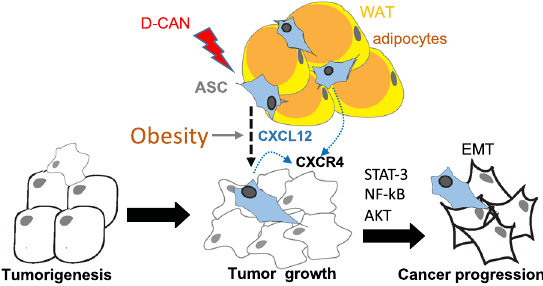
Fig. 6 The model of CXCL12 role in cancer progression. Adipose stromal cells (ASC) derived from WAT are the principal source of CXCL12 driving cancer by increasing the survival and proliferation of cancer cells and subsequently their EMT and aggressiveness via CXCR4-mediated signaling. Lightning bolt: D-CAN as a proof-of- principal experimental therapeutic that can be used to deplete ASC and suppress cancer